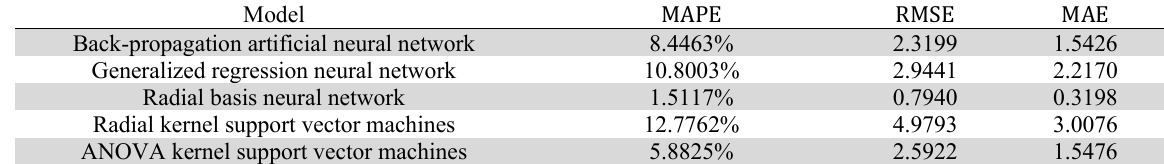
ANOVA kernel support vector